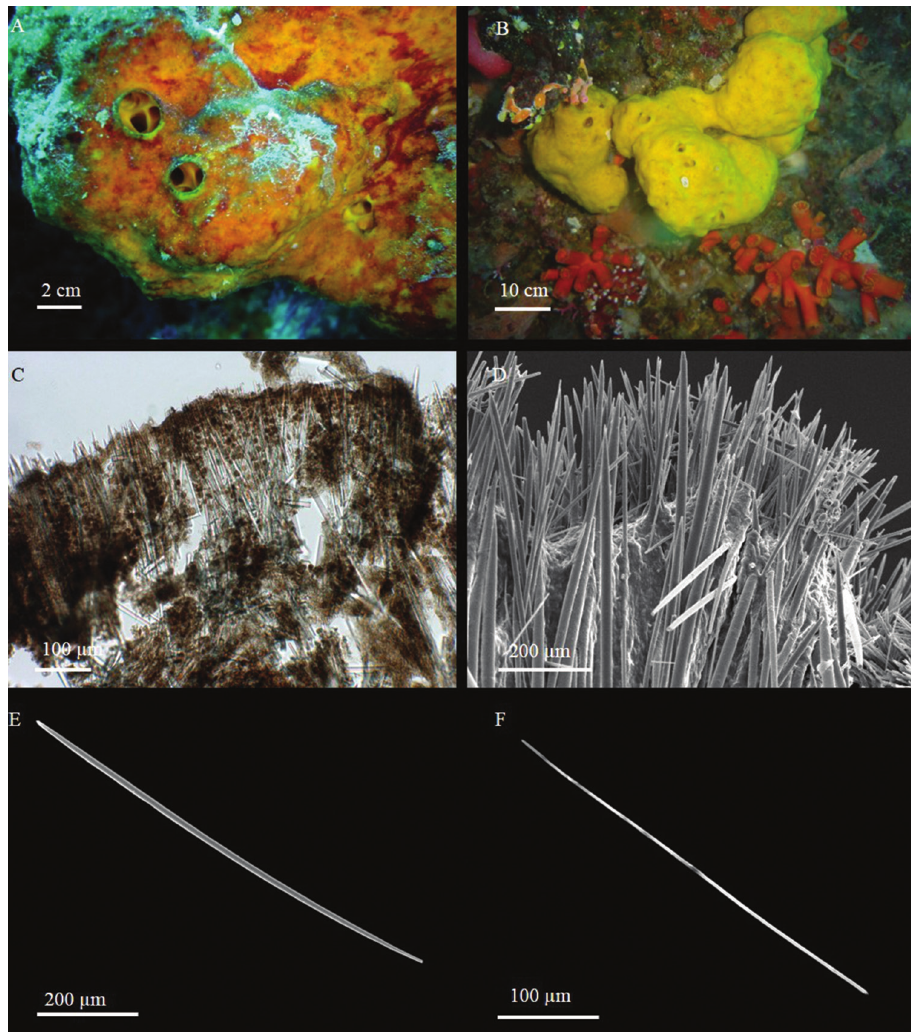
Figure 2. Aaptos lobata sp. n. A, B specimens in situ : A holotype B paratype C skeleton organisation (transverse section) D peripherical part of the skeleton E large strongyloxea F thin